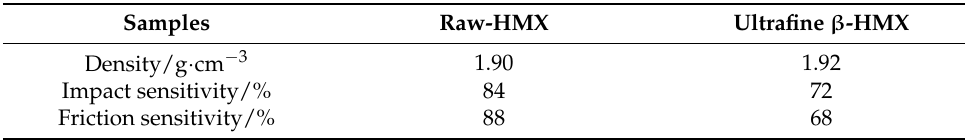
Table 4. Sensitivity and density data of ultrafine and raw HMX.